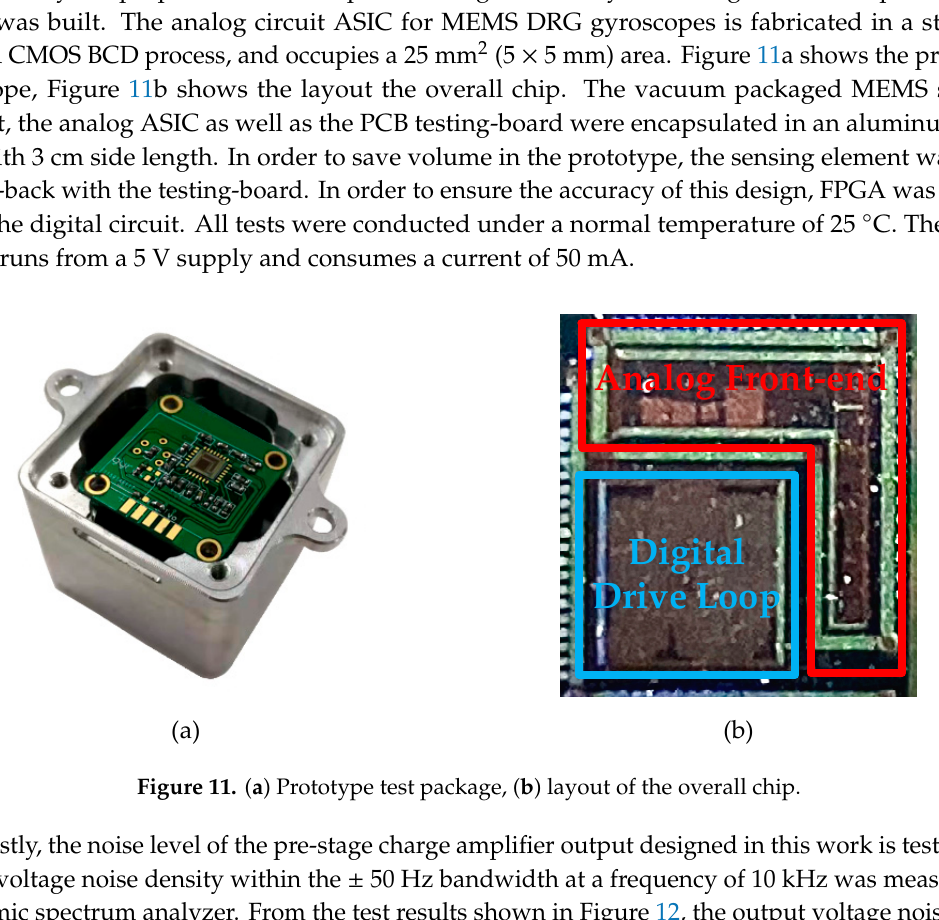
Figure 10. Power spectral density ( PSD) of the proposed ΣΔ modulator.